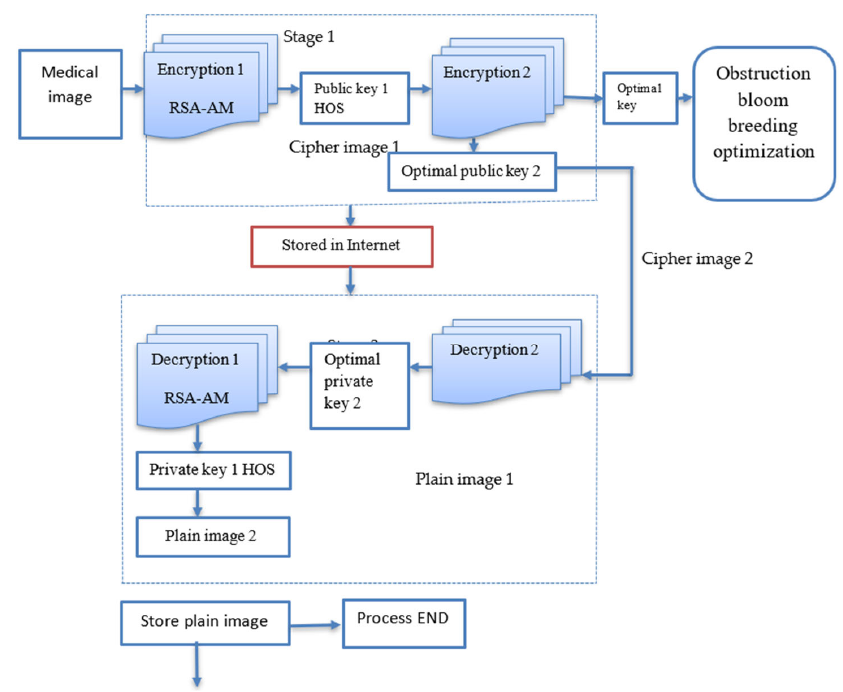
Figure 1. Block diagram of proposed work.